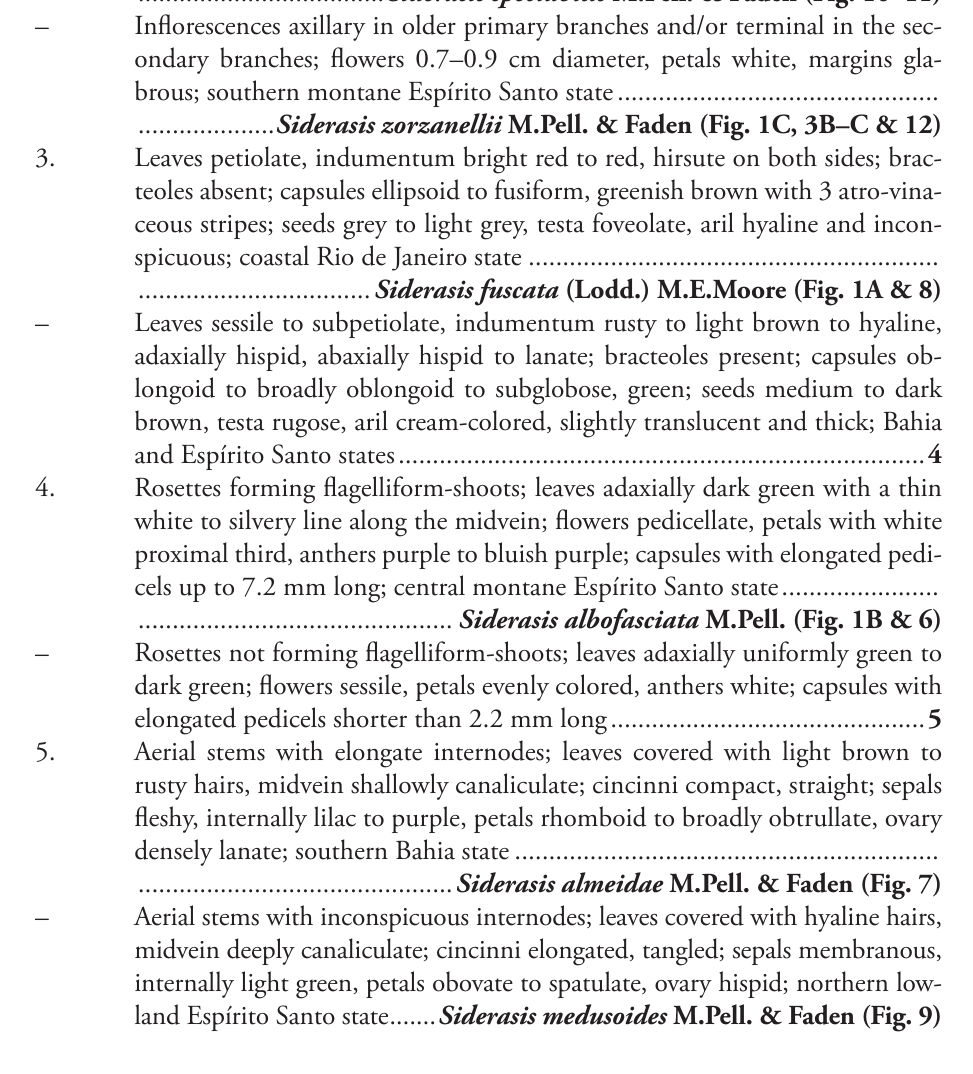
– Inflorescences axillary in older primary branches and/or terminal in the sec- ondary branches; flowers 0.7–0.9 cm diameter, petals white, margins gla-